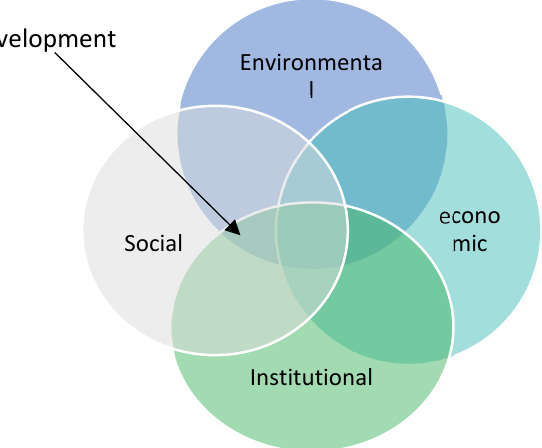
Fig. 1: The proposed diagram of sustainable development